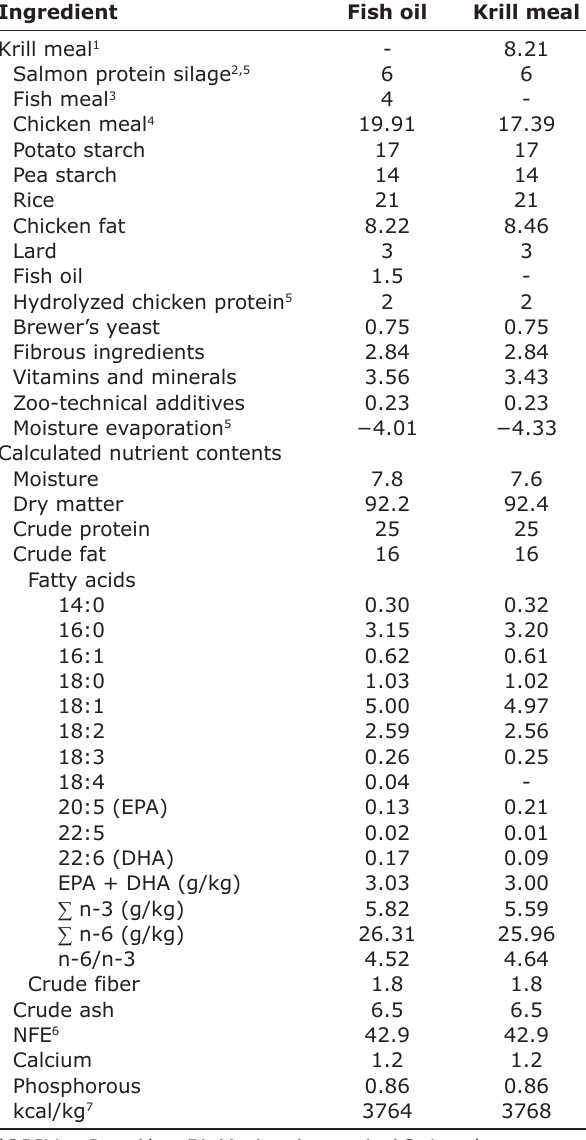
Table-1: Ingredient composition and calculated content (percent, unless otherwise stated) of the experimental diets.